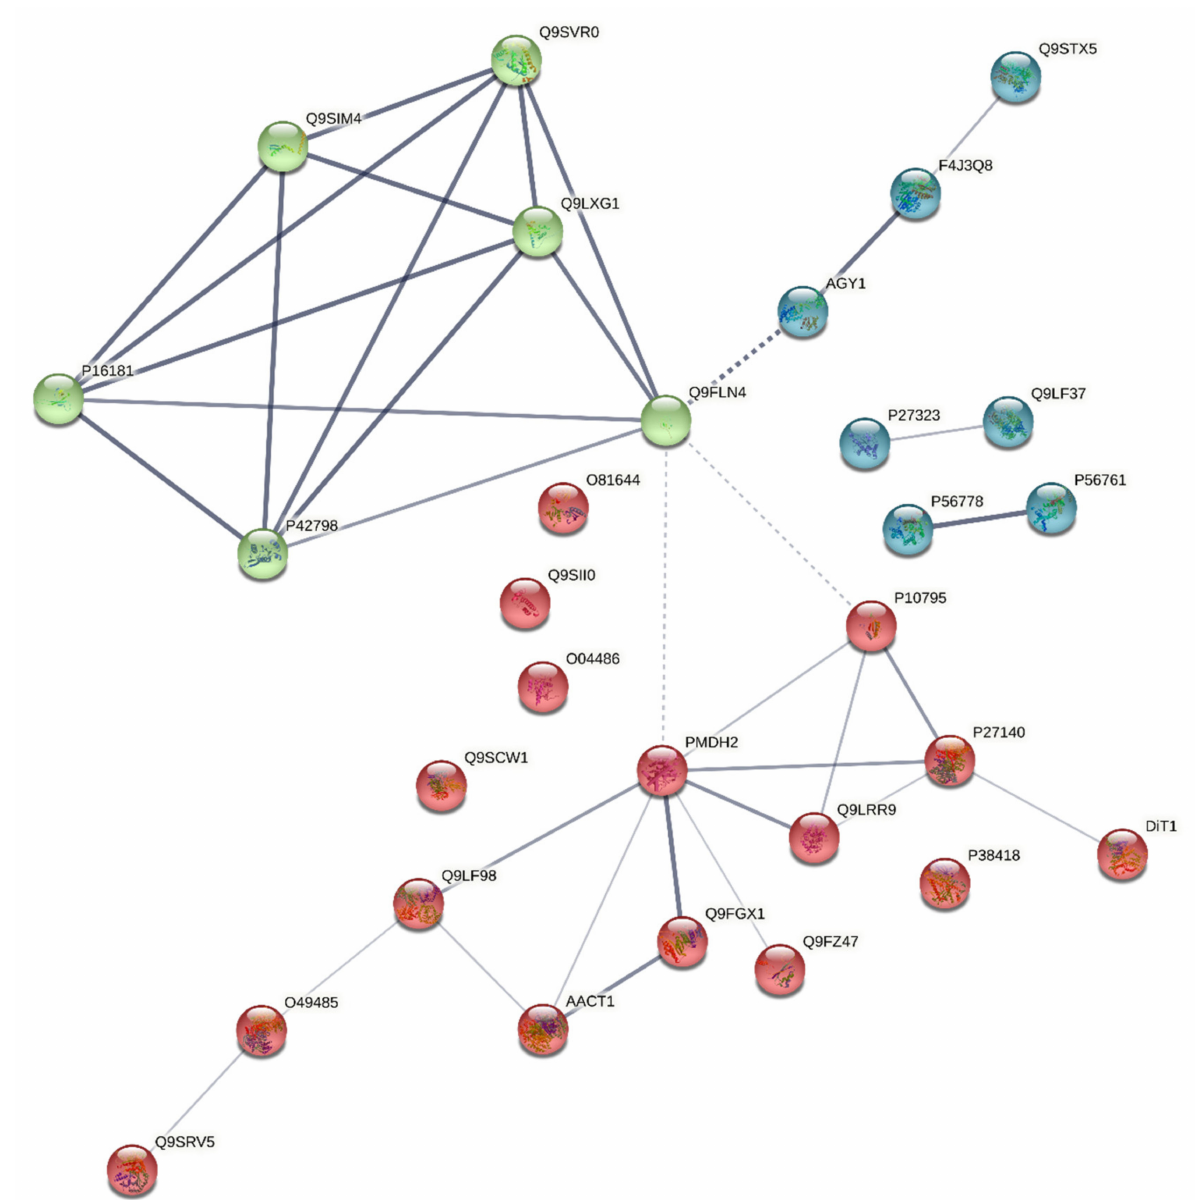
Figure 7. The PPI network of the S-R3 protein set was constructed using the k-means clustering method and shows 3 clusters identified by the colours green, blue, and red. Line thickness expresses the degree of confidence (from zero to one) associated with the interactions between proteins. Blue cluster proteins are functionally associated with photosynthesis; red cluster proteins are associated mainly to glyoxylate and dicarboxylate metabolism, carbon fixation in photosynthetic organisms, and citrate cycle; and green cluster proteins are associated with